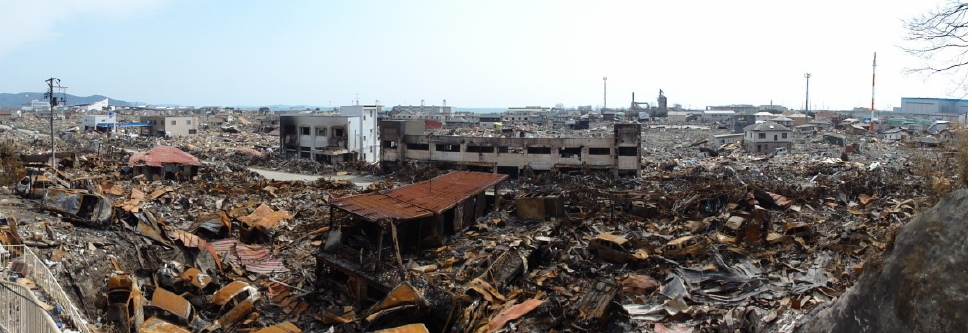
Figure 1. Tsunami debris and fire damage around Kadonowaki, Ishinomaki City—from Imai et al. [6].